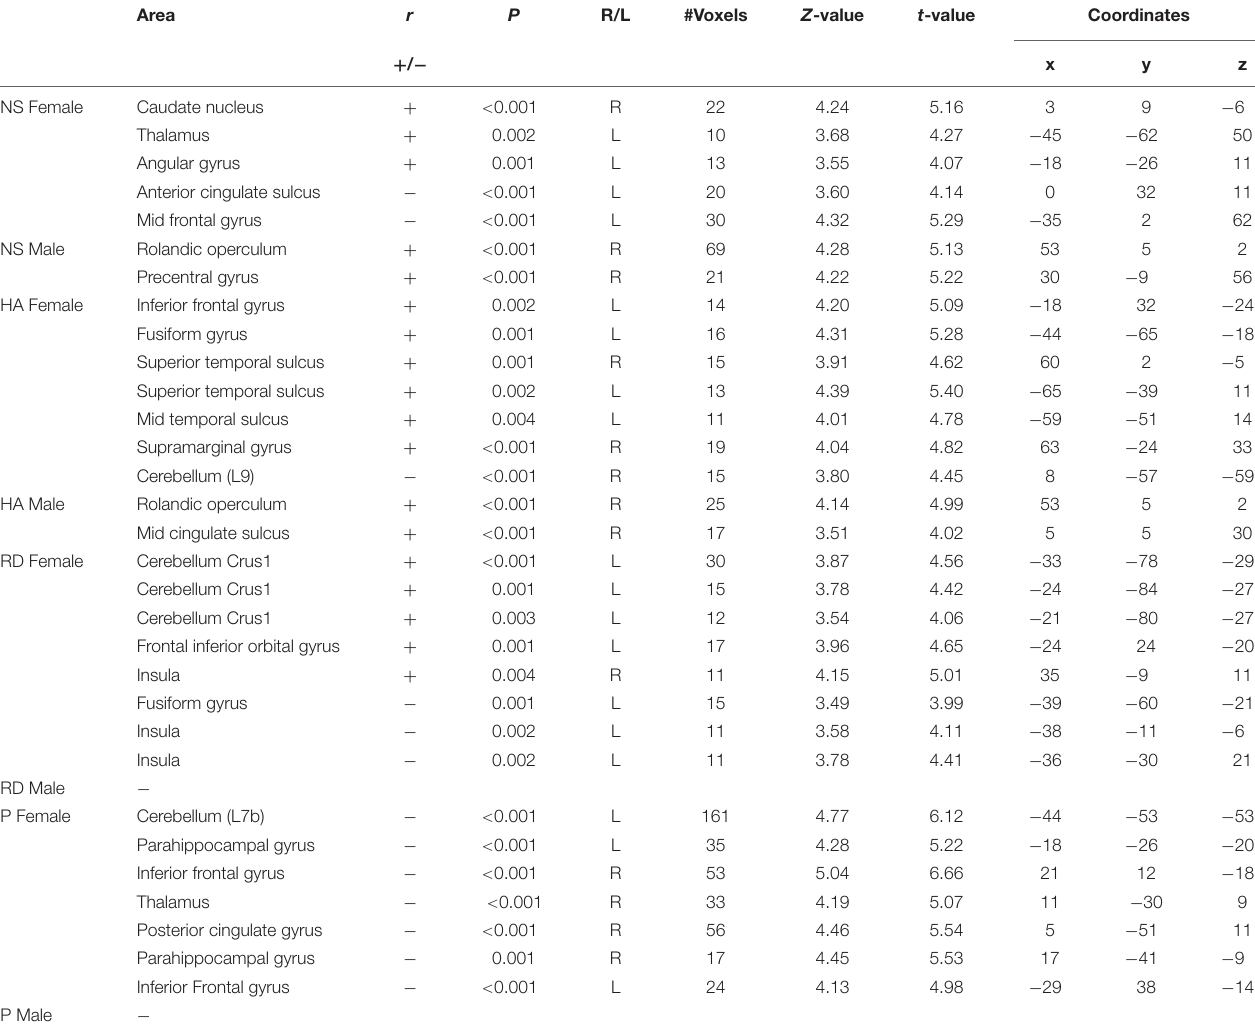
Overview Multiple regression results [P height < 0.001 (k = 10), combined with SVC, FWE-corrected at cluster level], investigating GMv associations with temperaments of the TCI; novelty seeking (NS), harm avoidance (HA), reward dependence (RD), and persistence (P) for males and females separately. Coordinates refer to MNI-space. L9, lobe 9; L7b, lobe